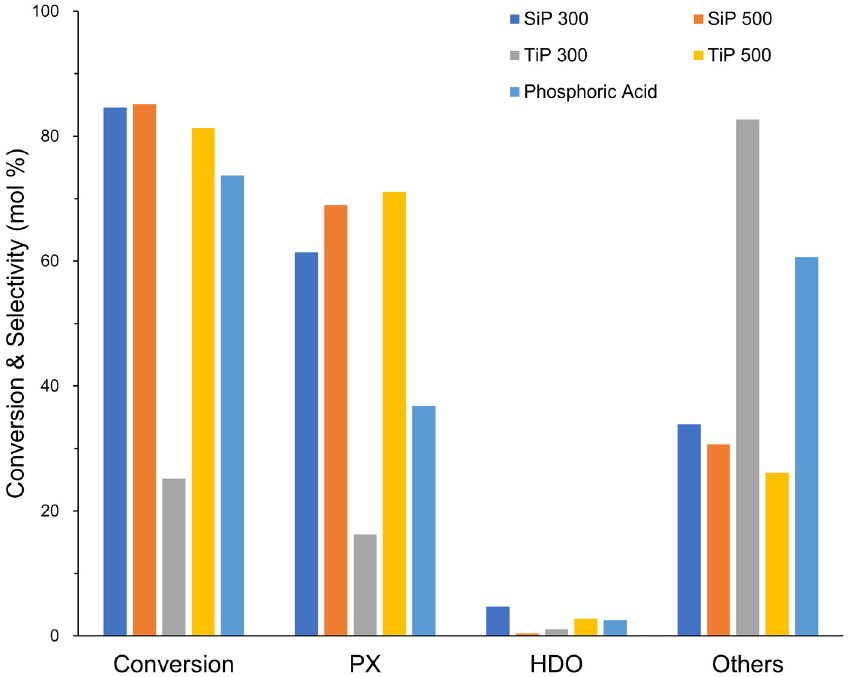
Figure 6. Conversion of DMF and selectivity of PX and HDO for the Diels–Alder reaction of DMF and ethylene over phosphated catalysts. Reaction condition; temperature = 523 K, reaction time = 6 h, C 2 H 4 pressure = 30 bar, DMF = 11.1 wt. %, catalyst mass = 300 ± 5 mg.